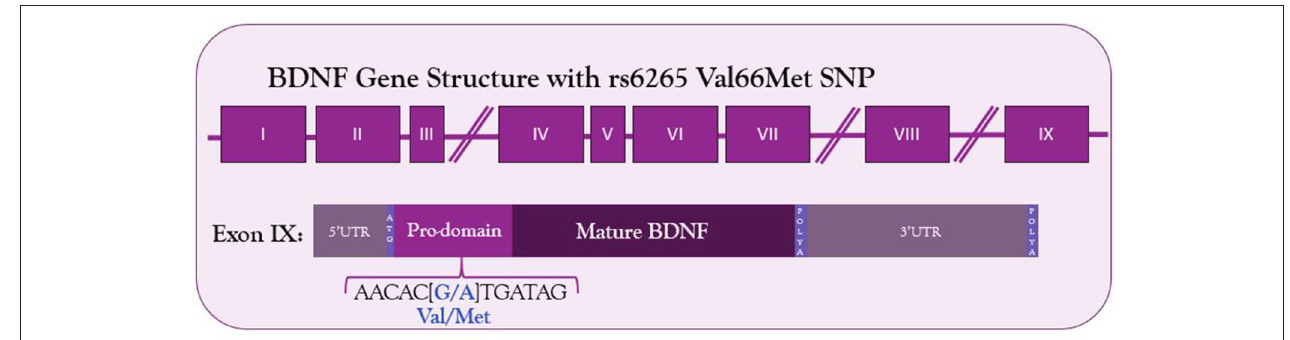
FIGURE 1 | Structure of BDNF gene and location of Val66Met SNP in the coding exon IX. The G to A substitution in the prodomain results in a valine to methionine substitution and decreased Ca 2 + -dependent release of